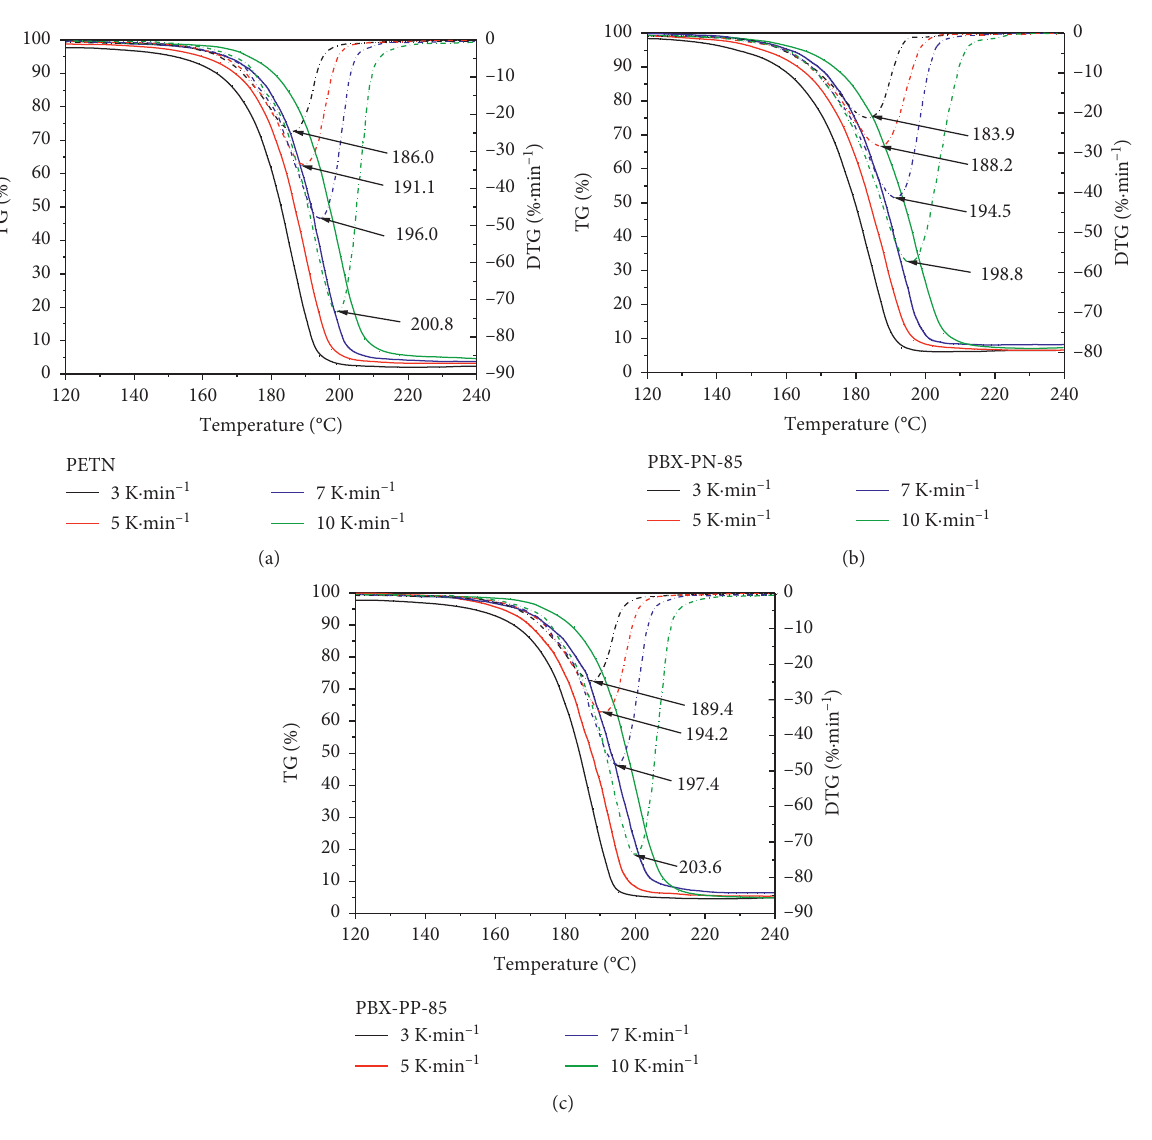
Figure 1: TG/DTG curves of PETN, PBX-PN-85, and PBX-PP-85 at several heating rates. Table 3: Kinetic parameters from TG/DTG data of PBX-PN-85, PBX-PP-85, and